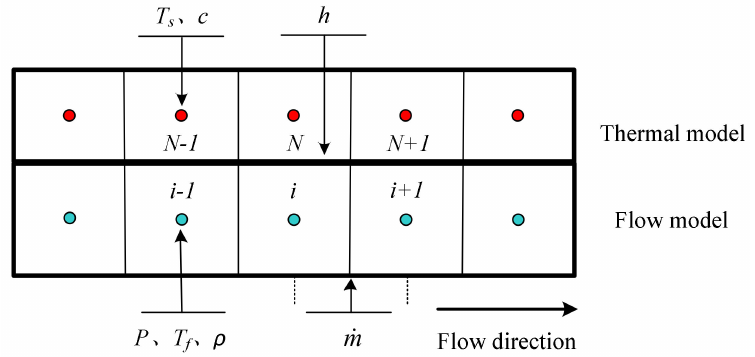
Figure 2. Schematic of thermal and flow